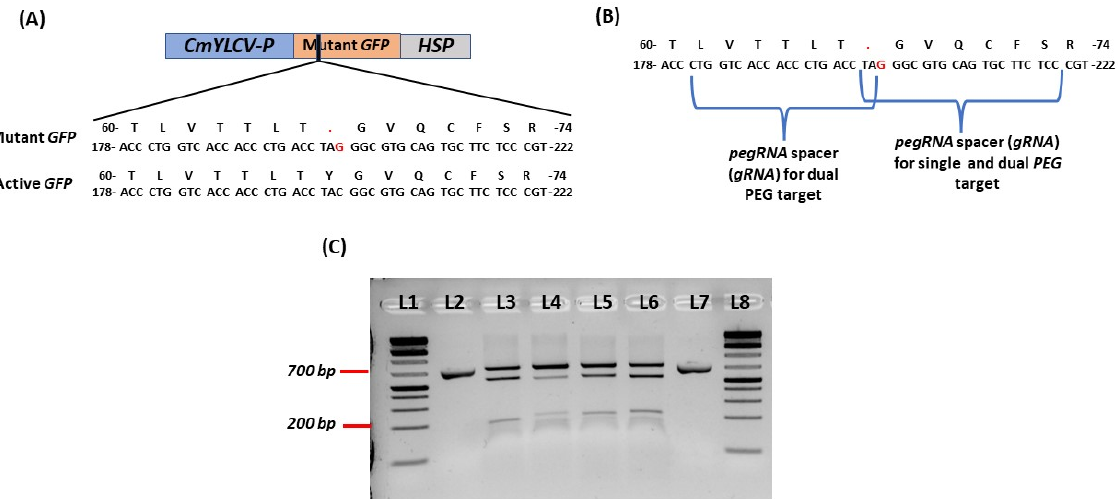
Figure 1. Design of mutant GFP and gRNAs. ( A ) map of mutant GFP; ( B ) position of pegRNA spacers/gRNAs for single pegRNA and dual pegRNAs; ( C ) in vitro RNP digestion of gRNAs using Cas9. L1 and L8: 1 kb+ ladders; L2 and L7: uncut amplicon from mutant GFP target region; L3: mutant GFP target region of sgRNA4 digested with Cas9 (expected bands of 531 bp and 190 bp); L4: mutant GFP region of sgRNA3 digested with Cas9 (expected bands of 518 bp and 203 bp); L5: mutant GFP region of sgRNA2 digested with Cas9 (expected bands of 522 bp and 199 bp); L6: mutant GFP region of sgRNA1 digested with Cas9 (expected bands of 521 bp and 200 bp).